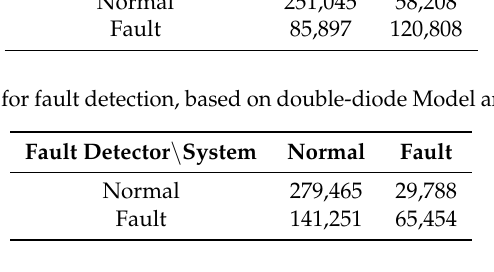
Table 7. Confusion matrix for fault detection, based on ARX model and an adaptive